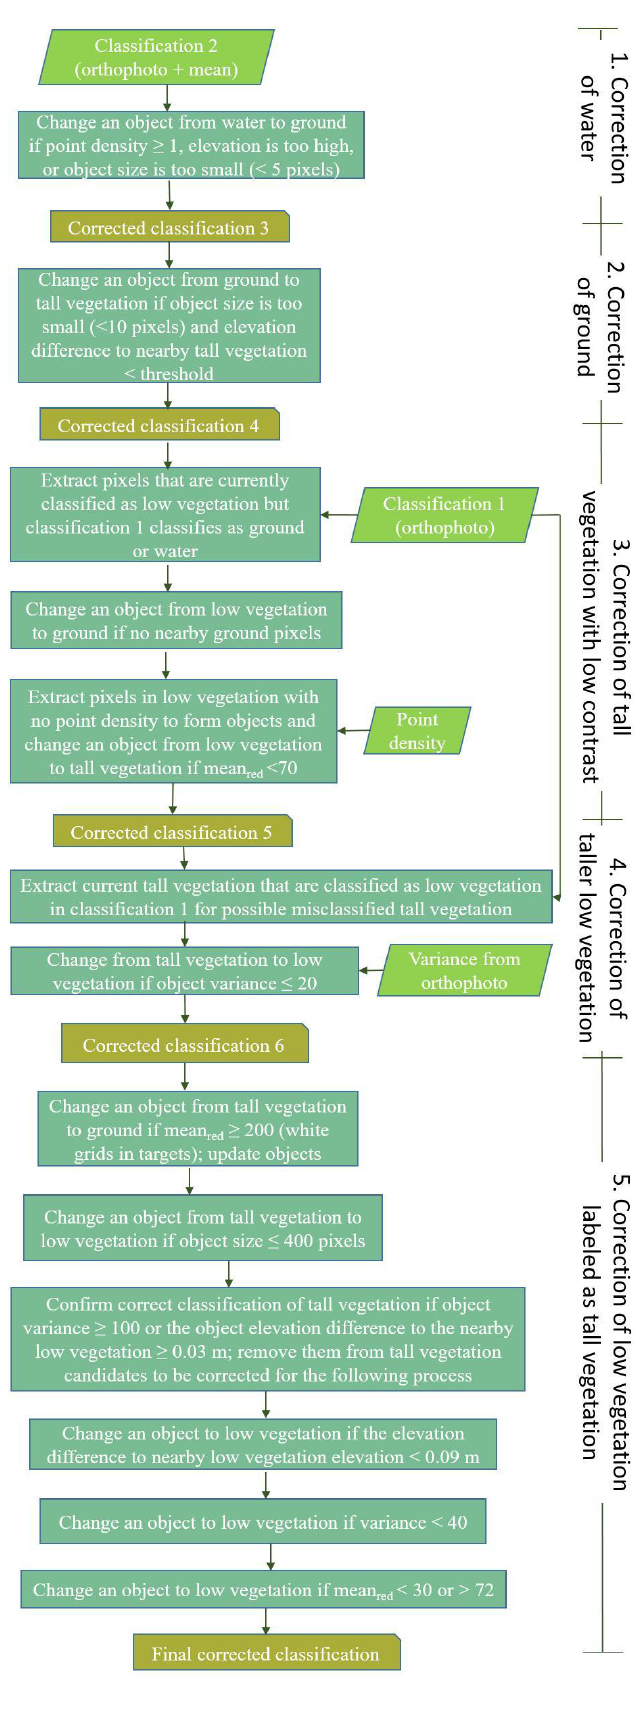
Figure 4. The flowchart of classification correction based on confusions between classes.